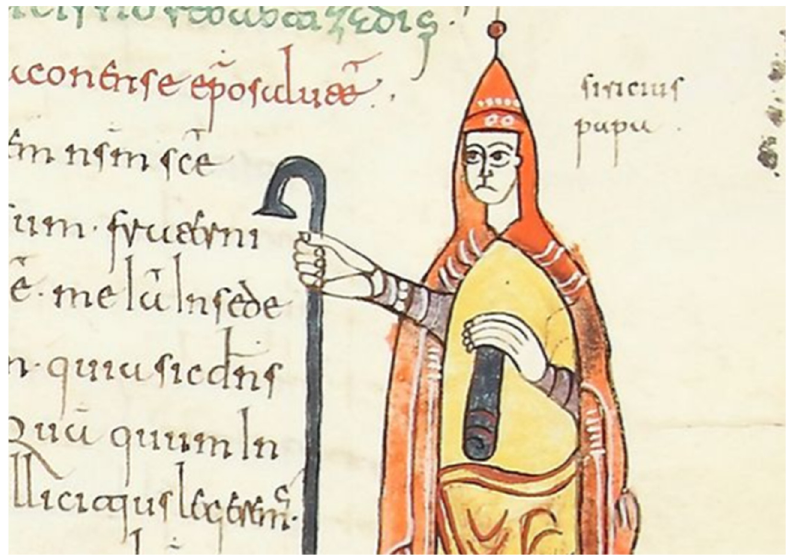
Figure 2. A pope wearing a chasuble (in a Isidorian meaning of casulla ) or an alb. Siricius papa . Detail from Codex Albeldensis (976), Real Biblioteca del Monasterio de el Escorial, cod. d-I-2 (2º), f. 254r. ©Patrimonio Nacional.